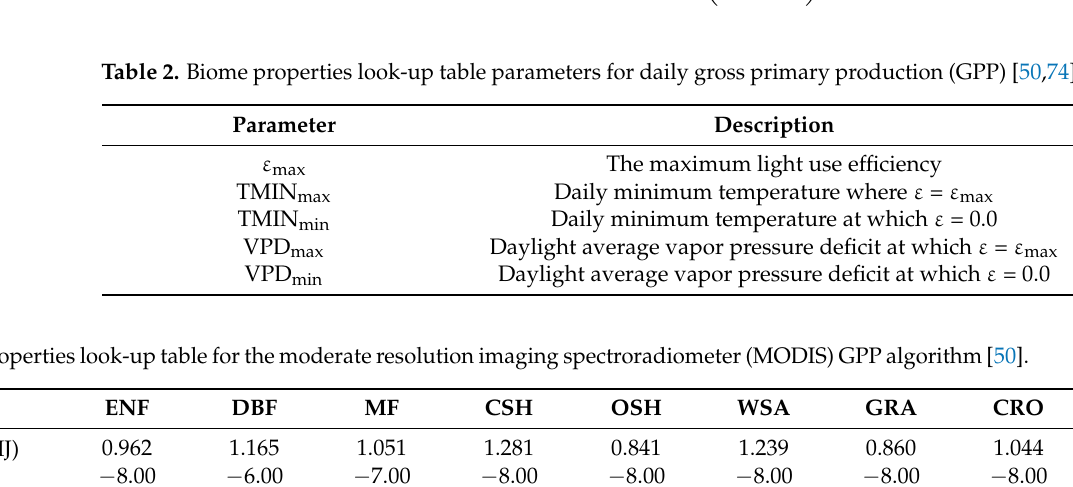
IPAR = SWRad ∗ 0.45